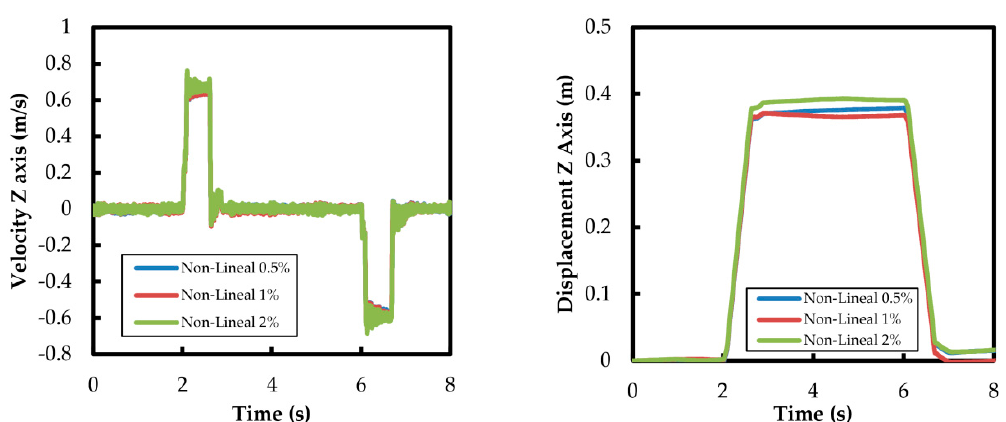
Figure 9. Calculated velocity and displacement for Z axis; Non-linearity error evaluation.